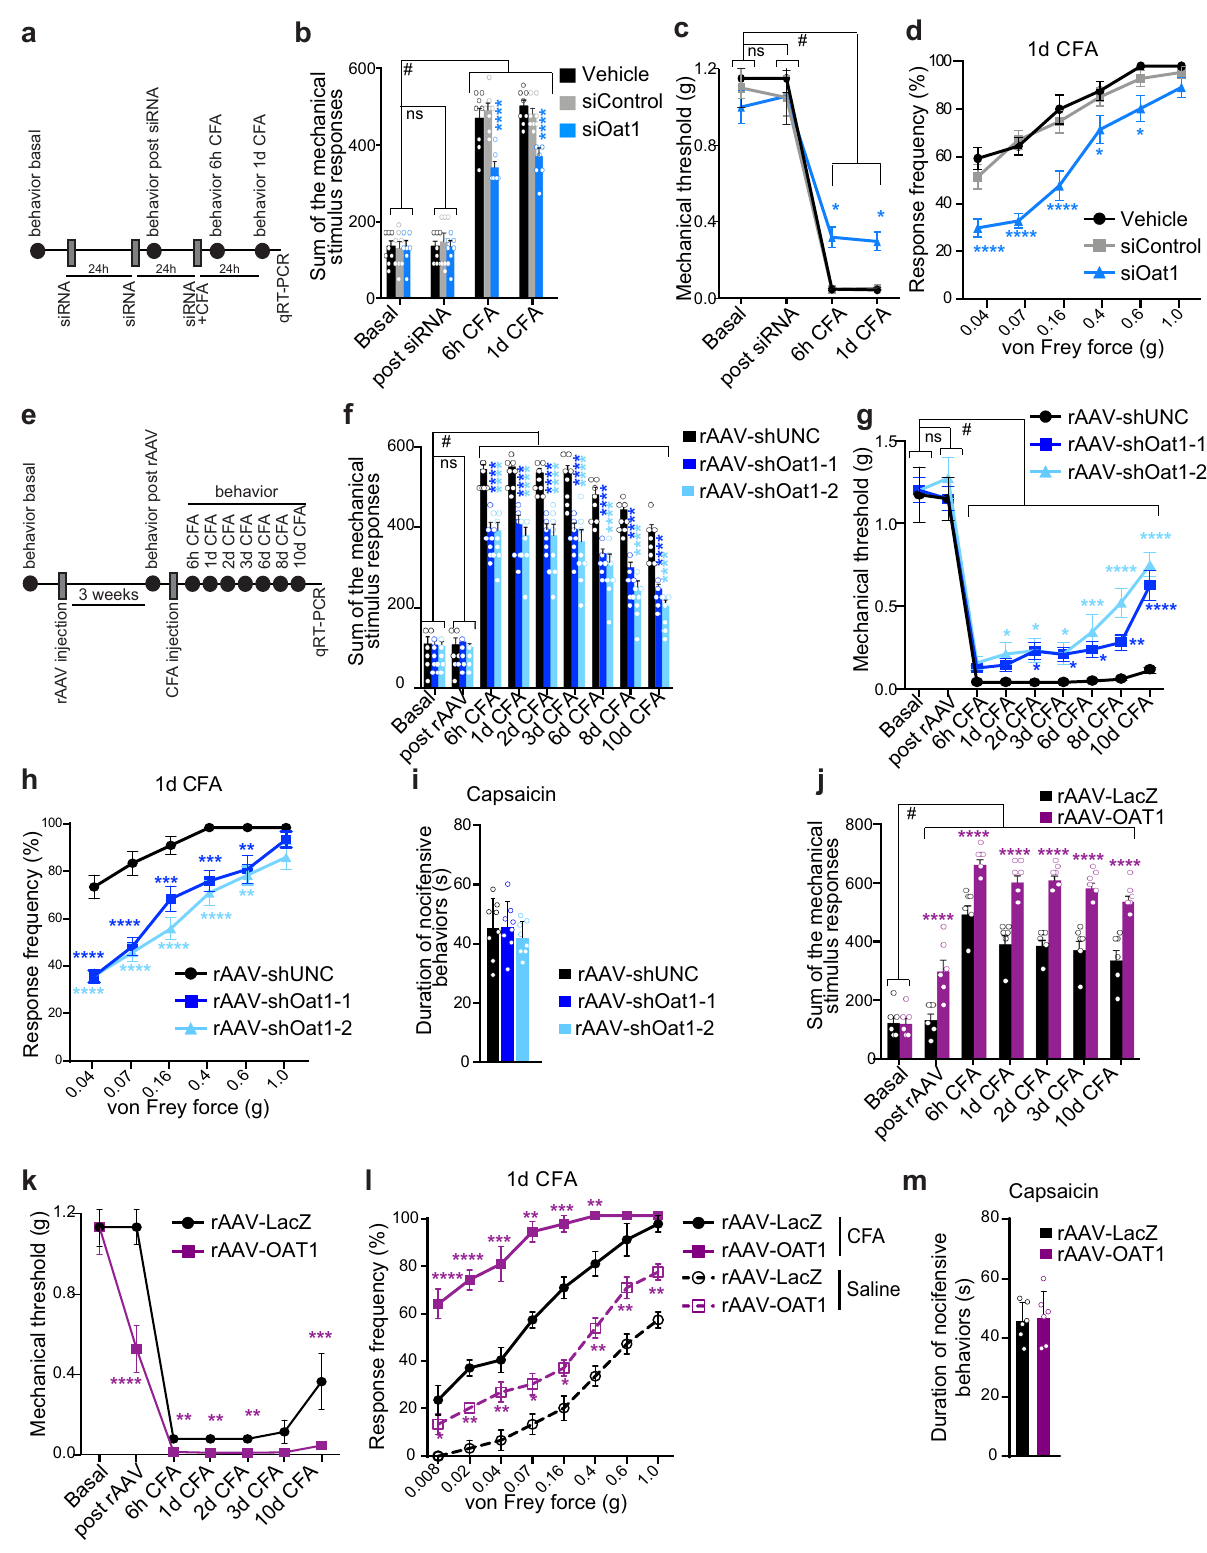
nervous system of in fl amed mice. Compared to vehicle-treated in fl amed mice, mice treated with PBN displayed signi fi cantly reduced CFA-triggered mechanical allodynia up to 24 h after a single intrathecal dose (Fig. 6a – c). PBN had no in fl uence on basal mechanical responses or on the development of CFA-induced thermal hyperalgesia (Fig. 6d). Thus, PBN inhibits the